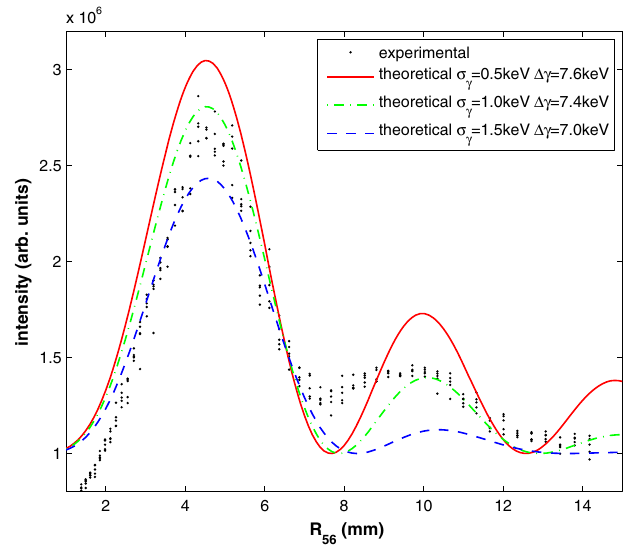
FIG. 8. Intensity of the second harmonic radiation as a function of the DS strength. The experimental data (black dots) can be fitted with theoretical lines with different parameters. Solid line: ¼ 0 : 5 keV , (cid:1) (cid:2) ¼ 7 : 6 keV ; dot-dashed line: (cid:3) ¼ 1 : 0 keV , (cid:3) (cid:2) (cid:2) (cid:1) (cid:2) ¼ 7 : 4 keV ; dashed line: (cid:3) ¼ 1 : 5 keV , (cid:1) (cid:2) ¼ 7 : 0 keV (cid:2)